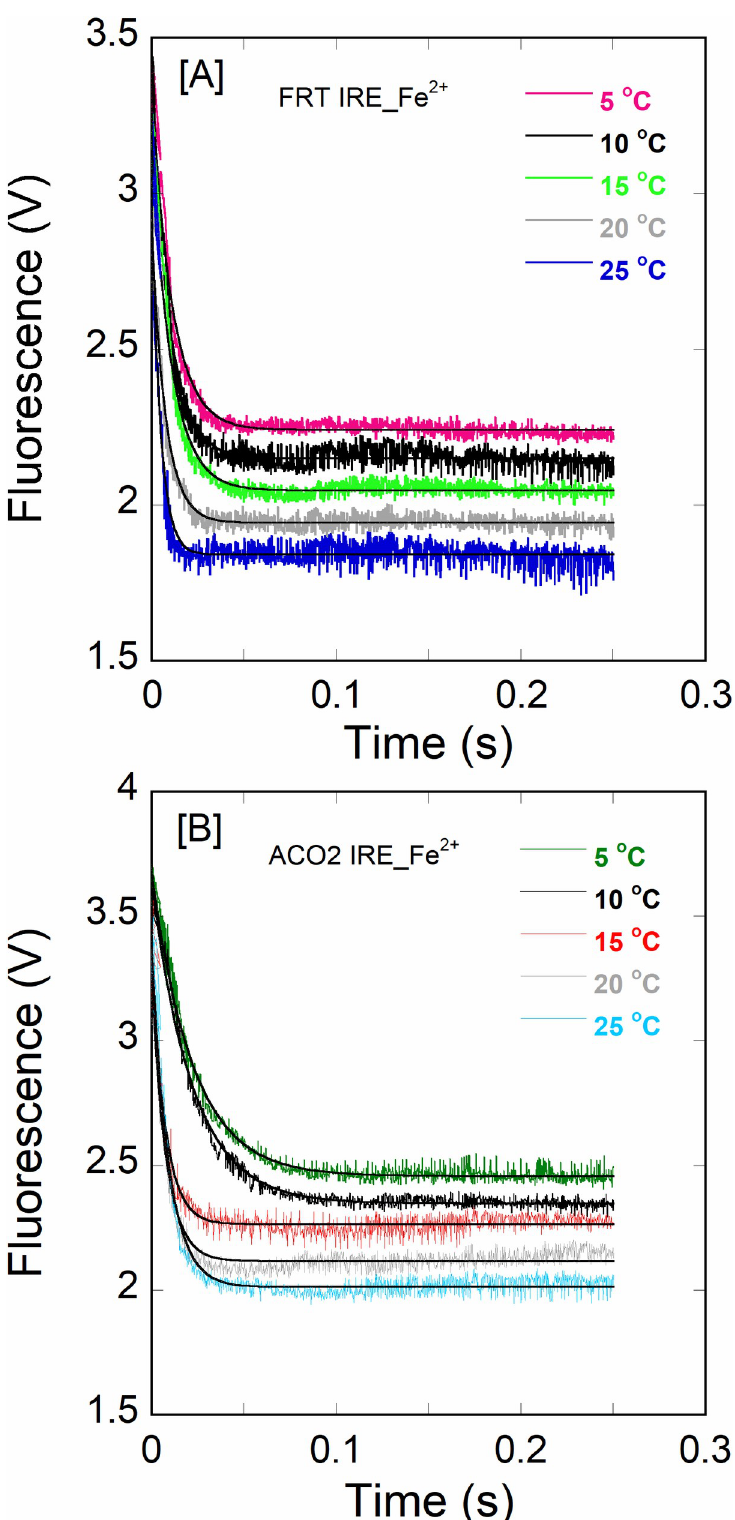
Fig 5. Temperature-dependent kinetic measurements of IRE RNA binding to eIF4F in the presence of iron. Kinetic plots show the time course of the interaction of eIF4F at 0.1 μ M (final) mixed with (A) FRT IRE RNA-Fe 2+